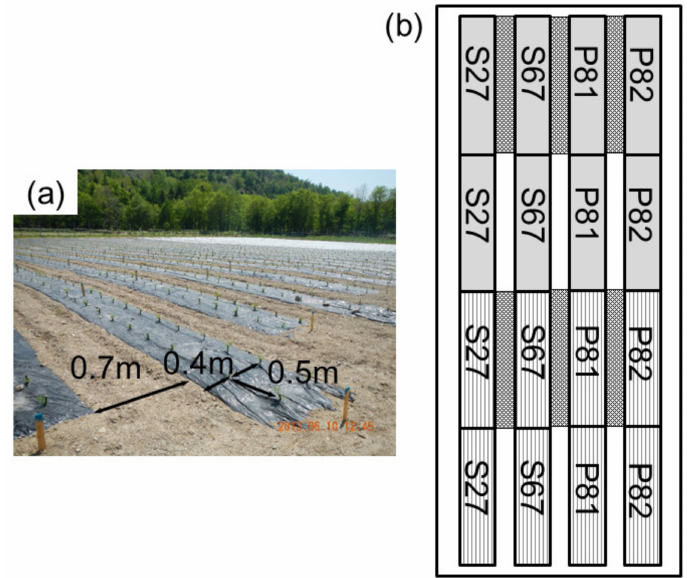
Figure 1. Experimental design: ( a ) double row planting of 20 cm long cuttings through mulch films, ( b ) layout of cutback and weed control treatments of two clones of Salix sachalinensis (S27, S67) and S. pet-susu (P81, P82) within a block. Vertical lines represent cutback and grey columns represent non-cutback treatments. White areas between the mulched areas represent weed-control treatments and black cross-hatching represent non-weed-control treatments,